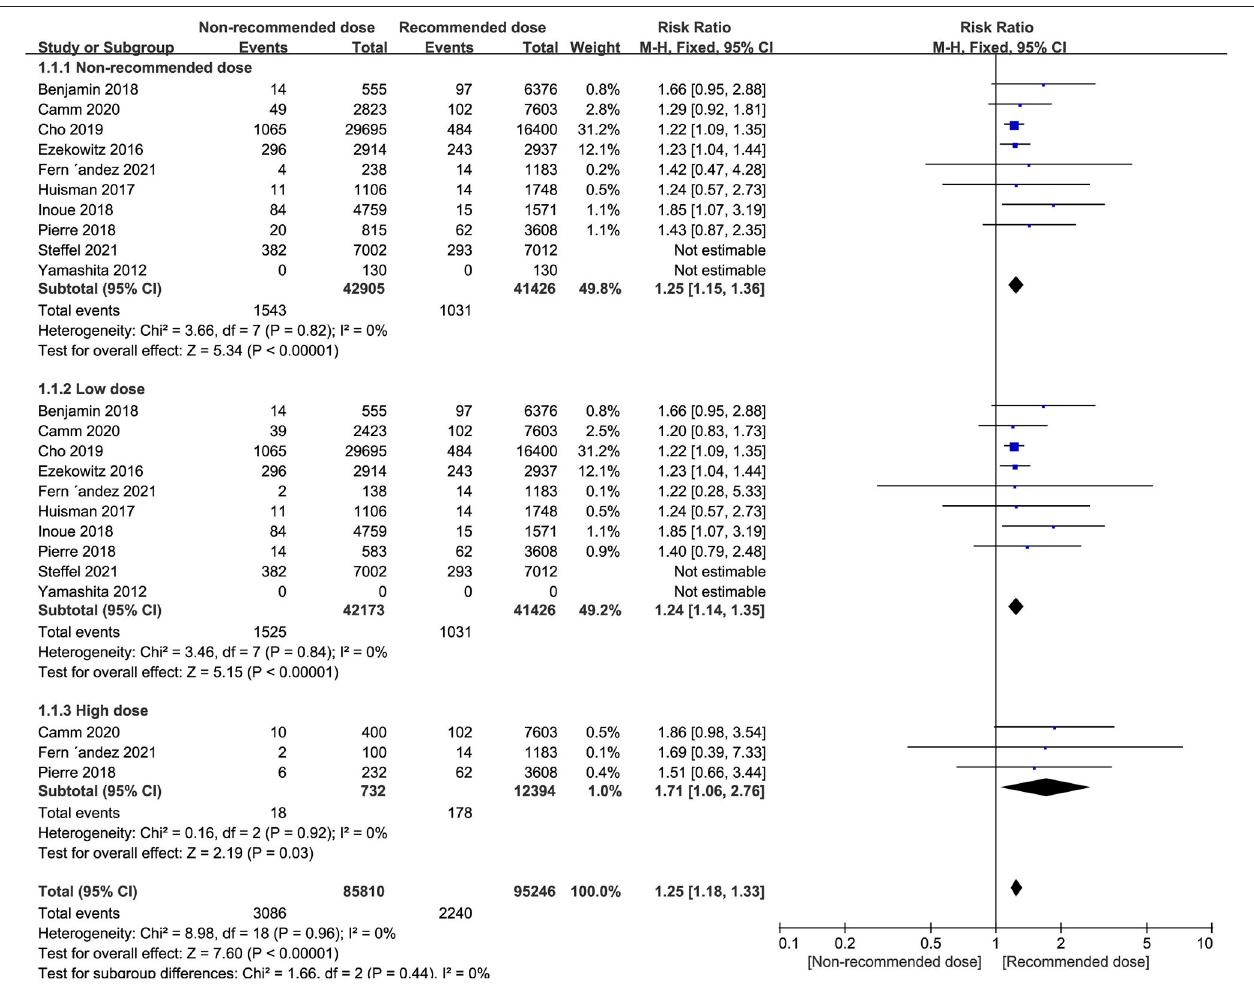
FIGURE 2 | Forest plot for stroke or systemic embolism in non-recommended dose compared to recommended dose of NOACs. NOACs, new oral anticoagulants.